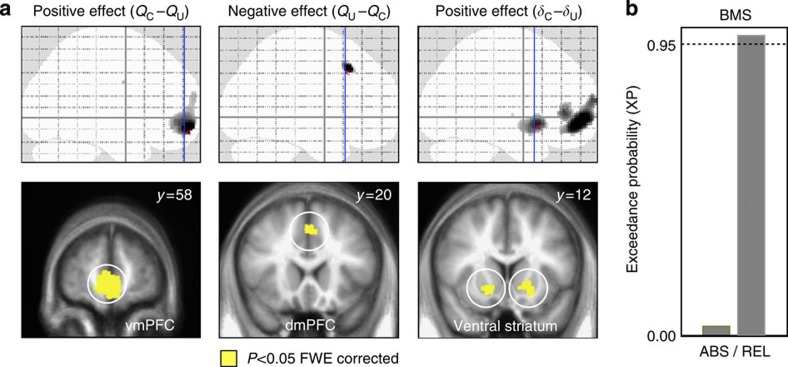
Neural model comparison.(a) Brain areas correlating positively and negatively with the difference between chosen and unchosen option value (QC-QU; left and central column), and correlating positively with the difference between chosen and unchosen prediction error (δC–δU; right column). Significant voxels are displayed on the glass brains (top) and superimposed to slices of the between-subjects averaged anatomical T1 (bottom). Coronal slices correspond to the blue lines on sagittal glass brains. Areas coloured in gray-to-black gradient on glass brains and in yellow on slices showed a significant effect (P<0.05, voxel level FWE corrected). Y coordinates are given in the MNI space. The results are from the GLM using the ABSOLUTE model parametric modulators (GLM1a). (b) Bayesian model comparison (BMS) of GLMs regressing ABSOLUTE (ABS) and RELATIVE (REL) option values and prediction errors (GLM1a and GLM1b). BMS is performed within the functional ROIs, presented on the left in yellow on the brain slices. Note that ROI selection avoids double dipping in favour of the hypothesis we aimed to validate, since the ROIs were defined from GLM1a (ABS) and GLM1a (ABS) was the hypothesis we aimed to reject.